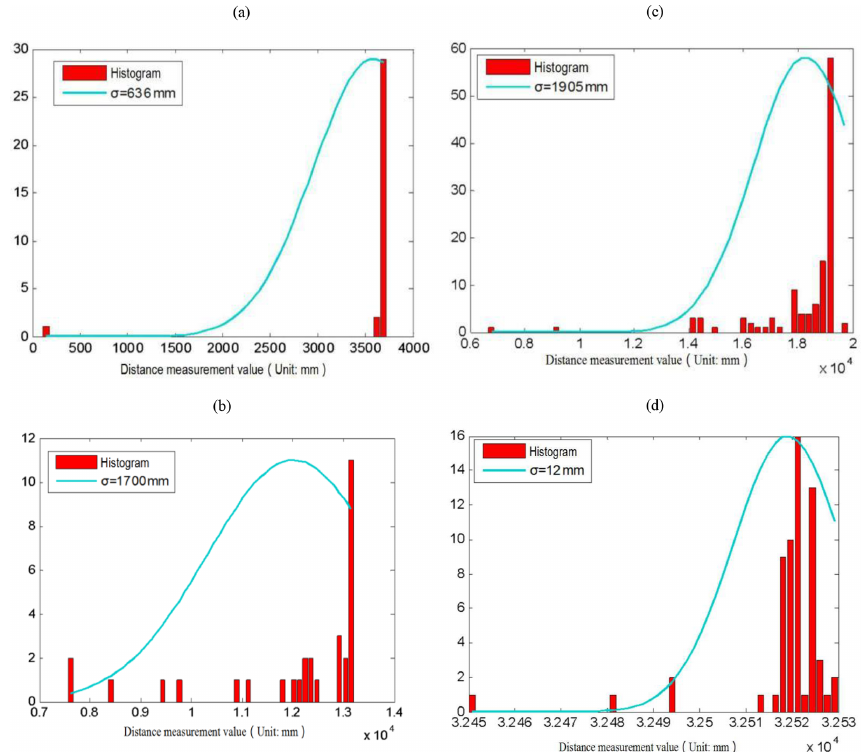
Figure 5. Statistical and probability density fitting results of measured values with small data volume. (a) Probability density at 3600mm.